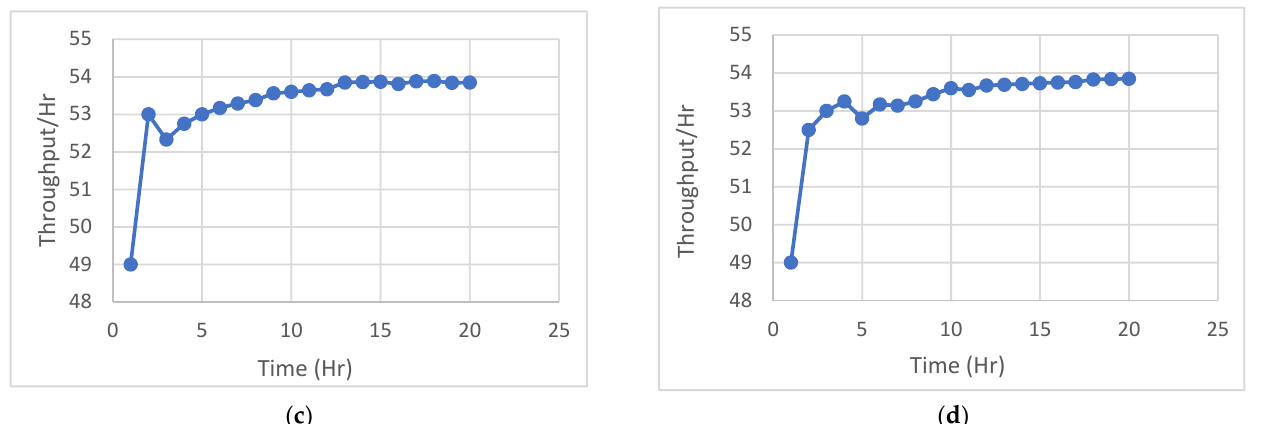
Figure 4. Plot of output to identify the warm-up period without breakdown of machines. ( a ) one degree. ( b ) two degrees. ( c ) semi-flexible. ( d ) fully flexible.